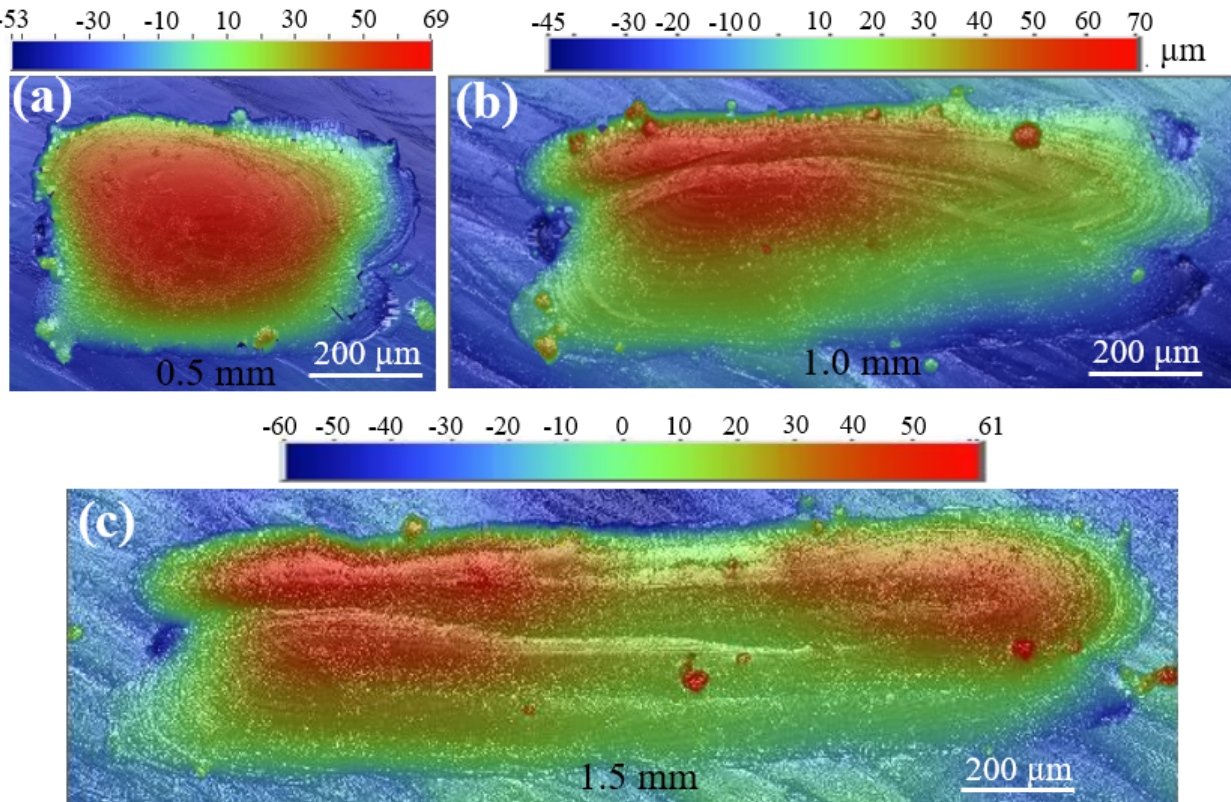
Figure 7. Multi − track profiles formed with 195 W, 750 mm/s, 120 µm hatch spacing and ( a ) 0.5 mm, ( b ) 1.0 mm, and ( c ) 2.0 mm scan length.